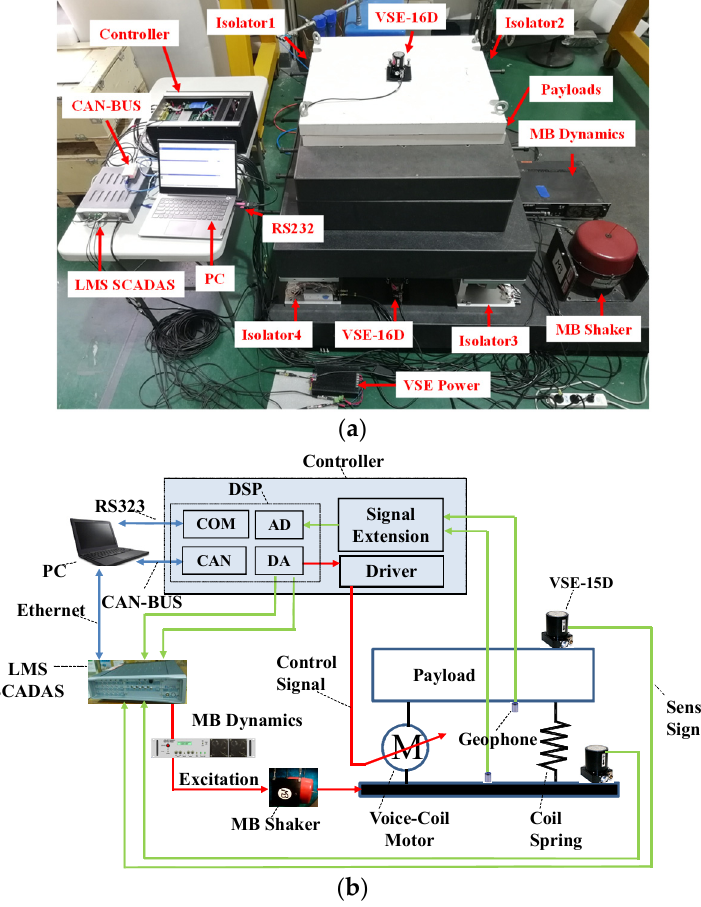
Figure 8. Experimental system: ( a ) experimental setup and ( b ) sketch of the experiment. Table 2. Specifications of components in AVRS.